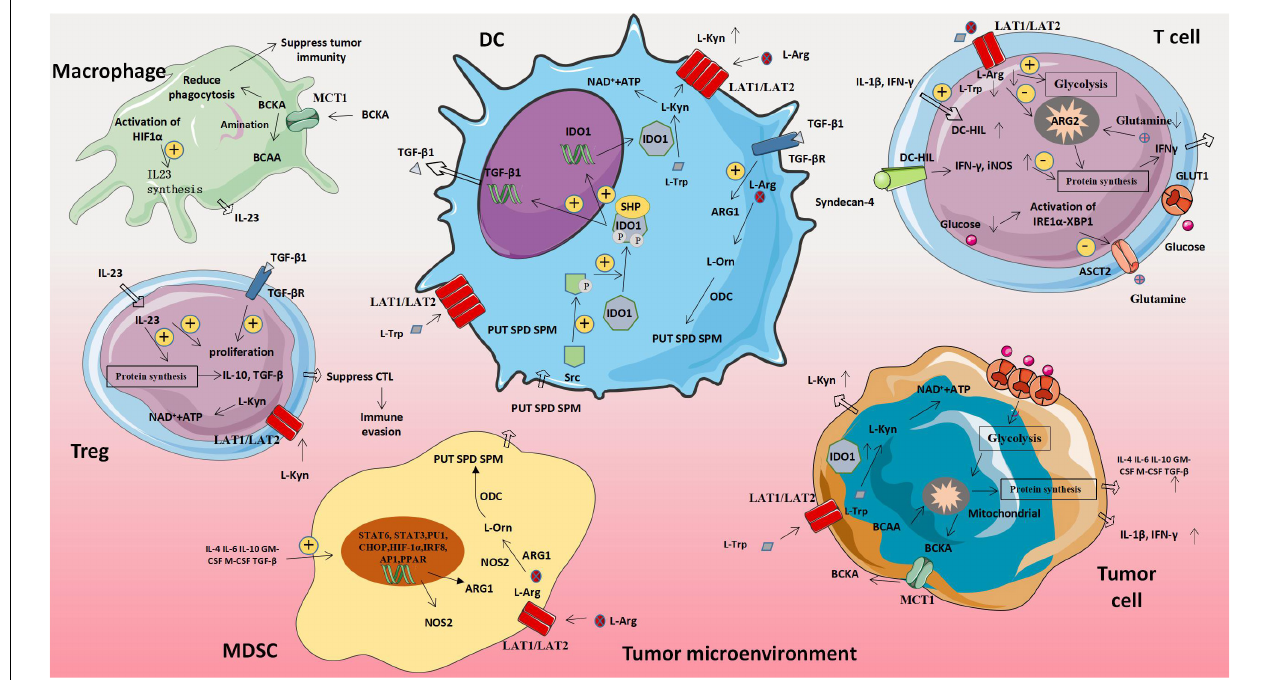
FIGURE 3 | Amino acid-related metabolic abnormalities and tumors. The metabolism of abnormal amino acids and amino acids related moleculars in tumor cells will affect the expression of metabolism-related genes in immune cells, thus leading to the increased expression of molecules that promote tumor proliferation and weaken anti-tumor immune effects. MDSC, Myeloid-derived suppressor cell; ARG1, Arginase 1; L-Orn, L-Ornithine; L-Arg, L -Arginine; L-Trp, L-Tryptophan; L-Kyn, L-Kynurenine; PUT, Putrescine; SPD, Spermidine; SPM, Spermine; ODC, Ornithine decarboxylase; NOS2, Nitric oxide synthase 2; BCAA, Branched chain amino acid; and BCKA, Branched keto